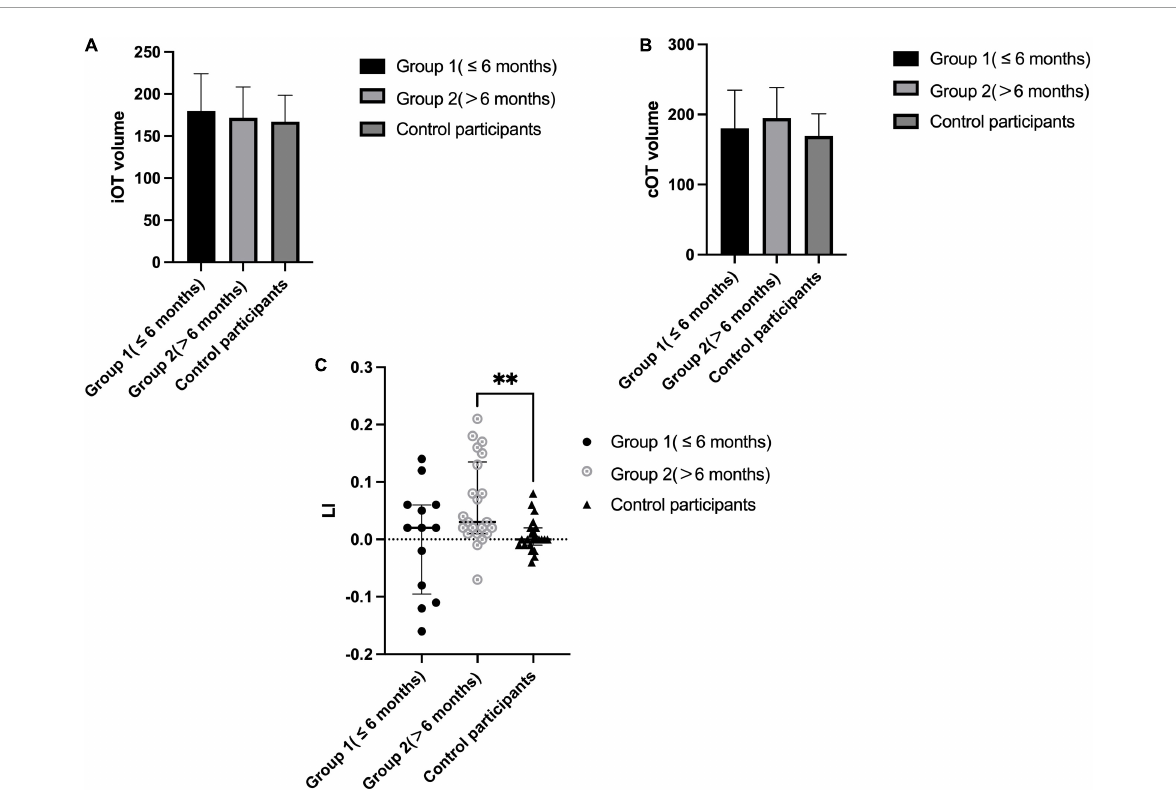
FIGURE3 Optic tract parameters in patients with thalamic stroke and comparison to control participants. (A) : Ipsilateral OT volume (voxel numbers) in Group 1 ( ≤ 6 months) and Group 2 ( > 6 months) patients and control participants (right side); (B) : Contralateral OT volume (voxel numbers) in Group 1 ( ≤ 6 months) and Group 2 ( > 6 months) patients and control participants (left side); (C) : LI in Group 1 ( ≤ 6 months) and Group 2 ( > 6 months) patients and control participants; ∗∗ P <